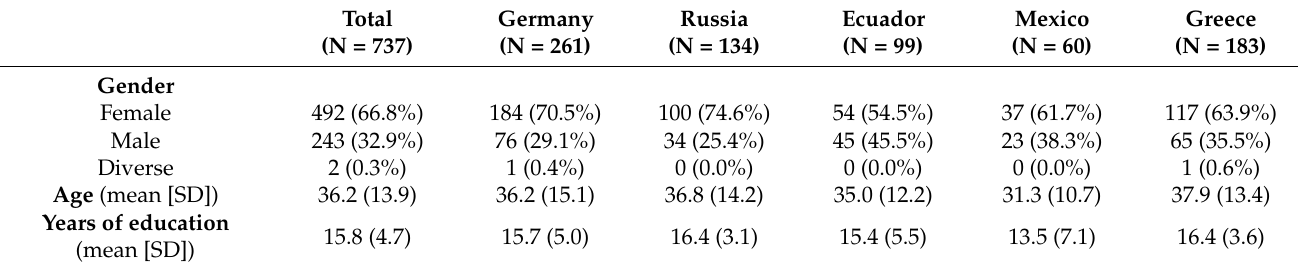
Table 1. Sample description by current country of